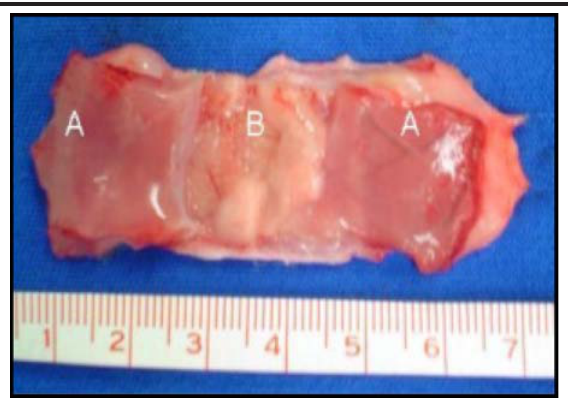
FIGURE 6 - Wall fragment removed for mechanical analysis in traction machine. Abdominal aponeurosis(A), implanted mesh(B).